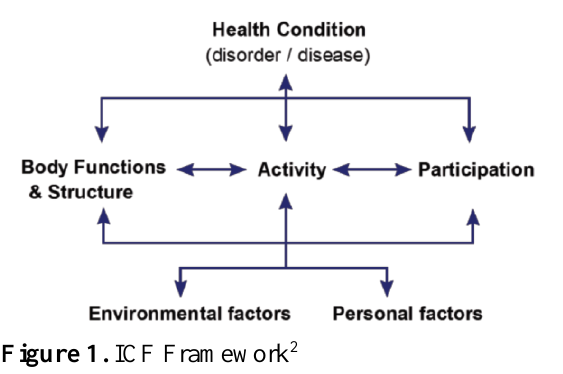
Figure 1. ICF Framework